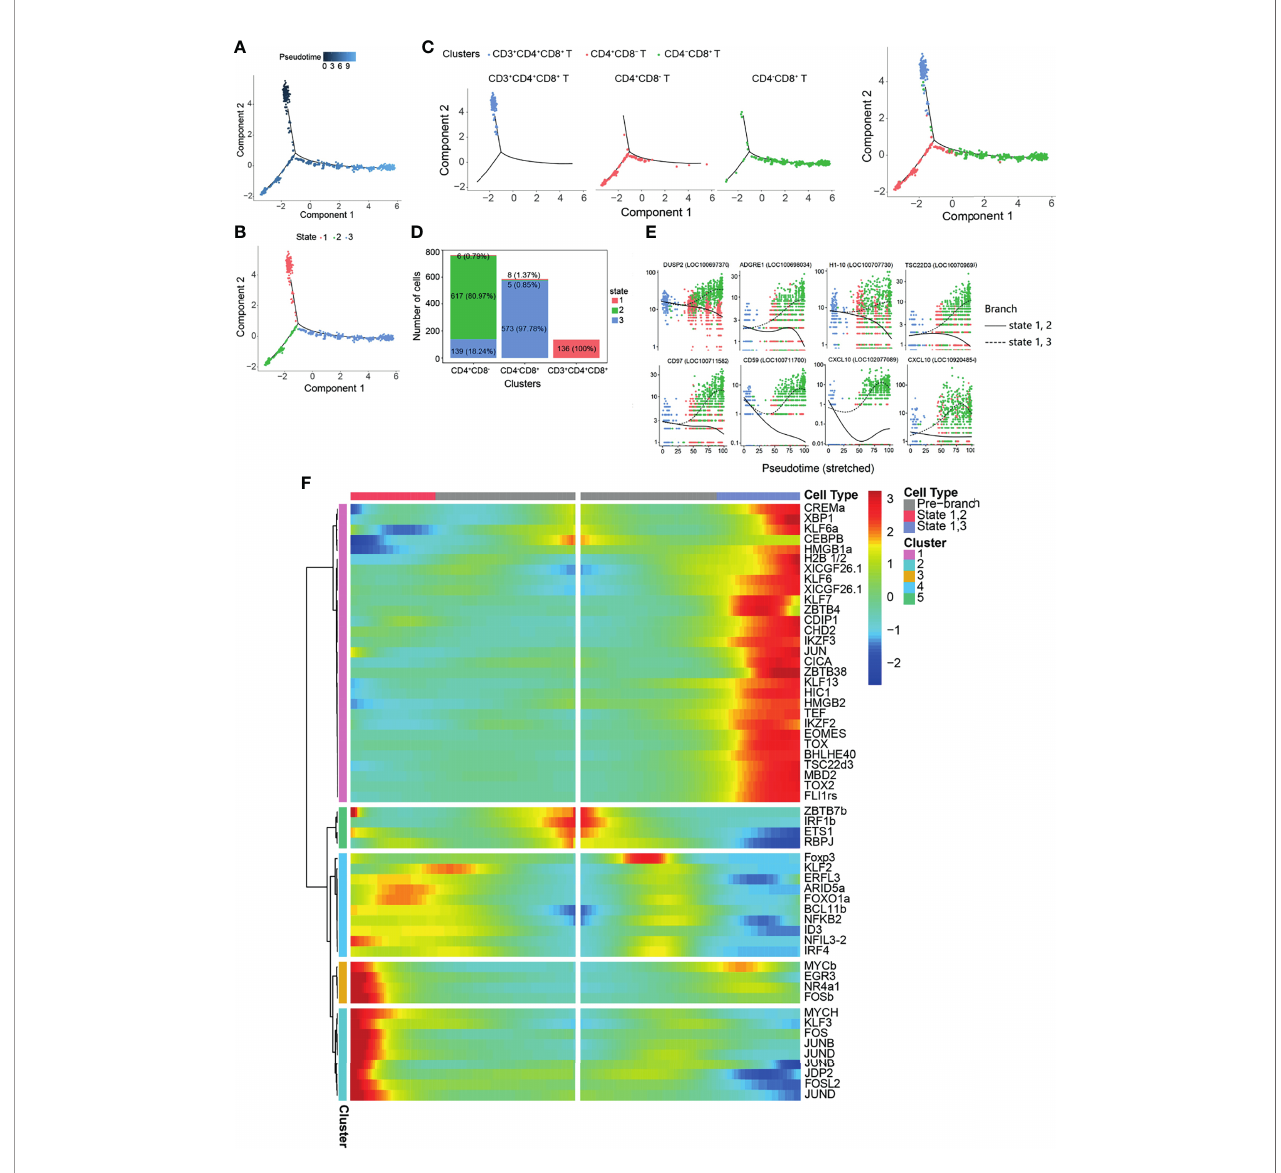
FIGURE 5 | Pseudo-temporal analysis of T-cell development with Monocle. (A) Trajectories of CD3 + CD4 + CD8 + , CD4 + CD8 − , and CD4 − CD8 + with pseudo-time analysis. (B) Distribution of the three trajectory states. (C) Distribution of the three T-cell subsets in the trajectory. (D) Cell numbers and percentages of each T-cell subset in the trajectory branches. (E) Monocle analysis revealing the progressive expressions of dual speci fi city protein phosphatase 2 ( DUSP2 ), adhesion G protein- coupled receptor E1 ( ADGRE1 ), histone H1.10 ( H1-10 ), TSC22 domain family protein 3 ( TSC22D3 ), CD97 , CD59 , and C – X – C motif chemokine 10 ( CXCL10 ) across pseudo-time in two branches. (F) Heatmap of the branch-dependent transcription factors (TFs) in the T-cell trajectory